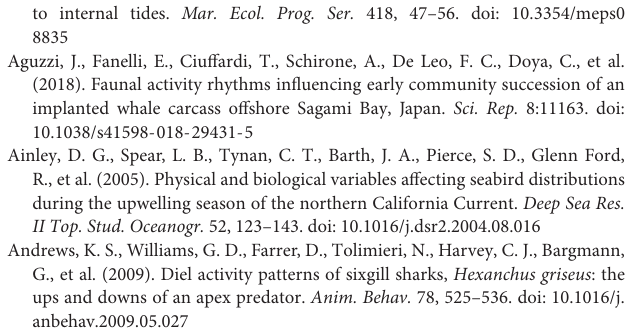
Supplementary Figure 2 | Tracks for 15 blue sharks overlaid on the average 2010/2011 sea surface temperature. Supplementary Figure 3 | Pearson residuals from GLMM between blue shark day-time occupancy above 250 m depth and environmental variables. Pearson residuals along (A) fitted values; (B) concentration of the chlorophyll a maximum and (C) temperature at depth (100 m). (D) Quantile-quantile plot for the